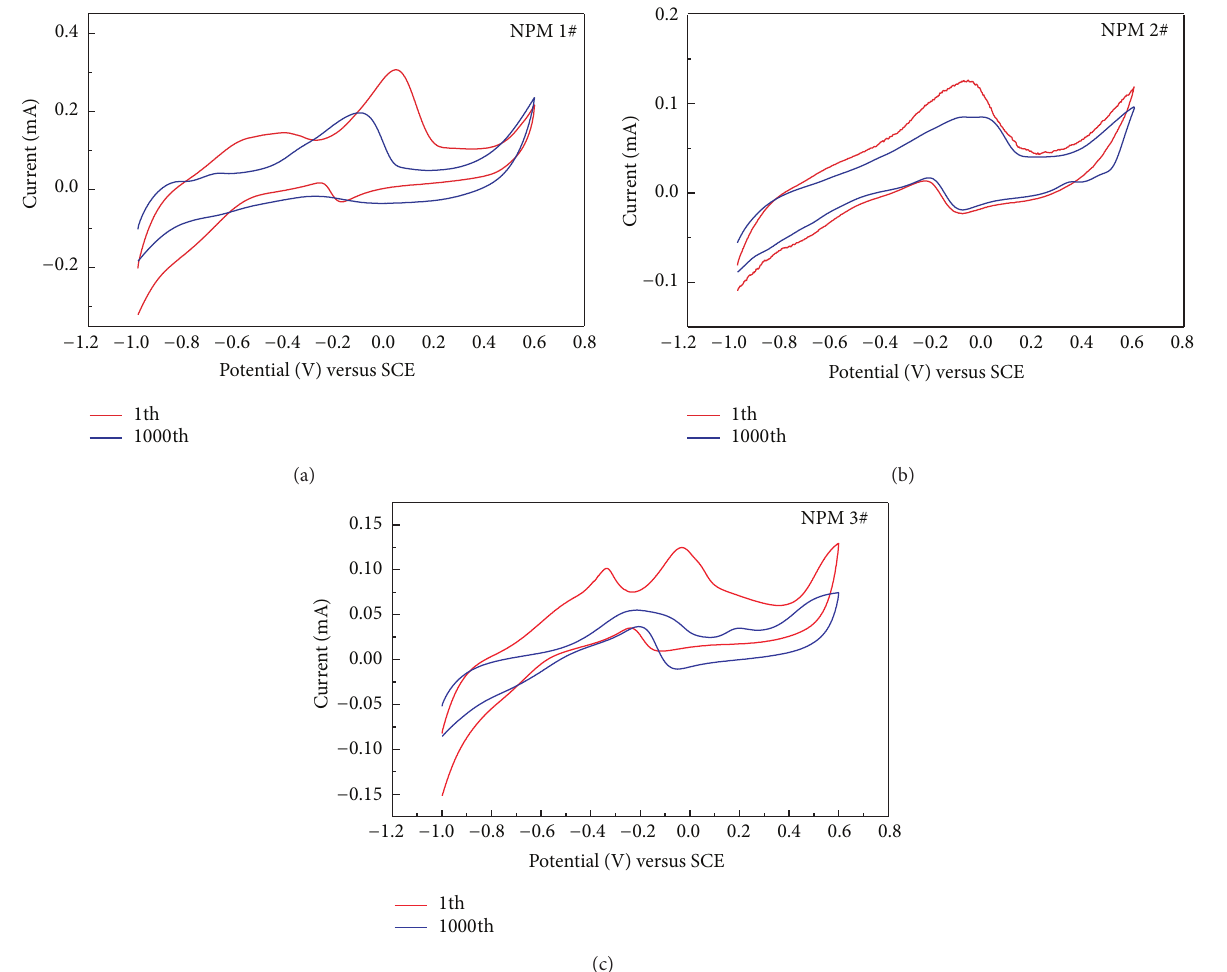
Figure 5: CV curves of the NPMs in 0.1M KOH solutions containing 50 mM glucose during 1000 potential cycles.